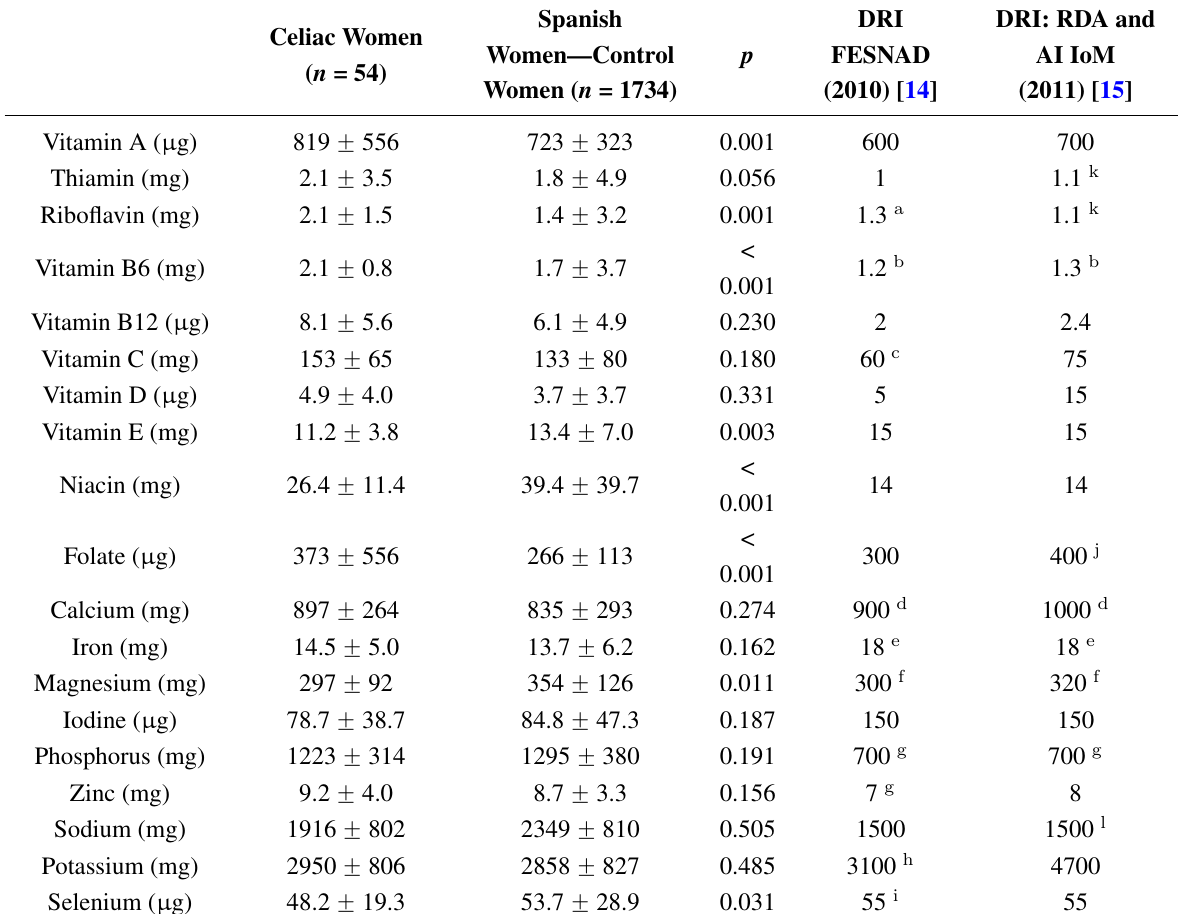
Table 3. Micronutrient intake in celiac and Spanish women compared to the FESNAD’ and IoM’